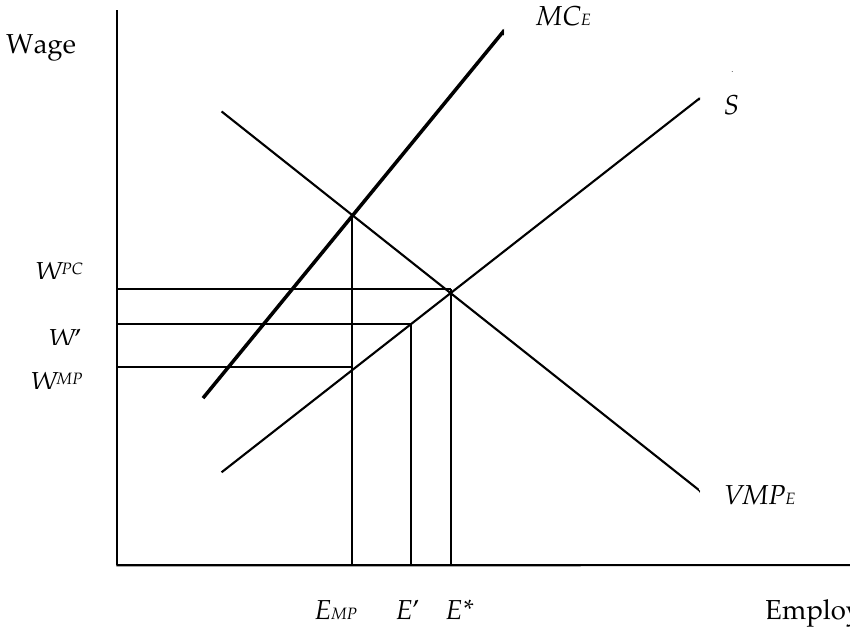
Figure 2. The employment effect of minimum wages in the monopsonistic market.